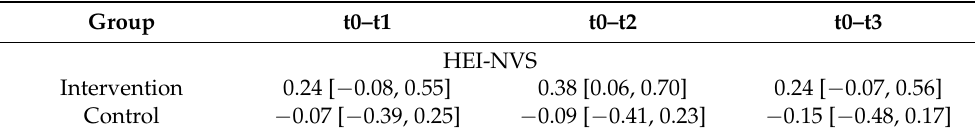
Table 4. Effect sizes (Cohen’s d) with 95% confidence interval of the HEI-NVS (ITT analysis) 1 . Group